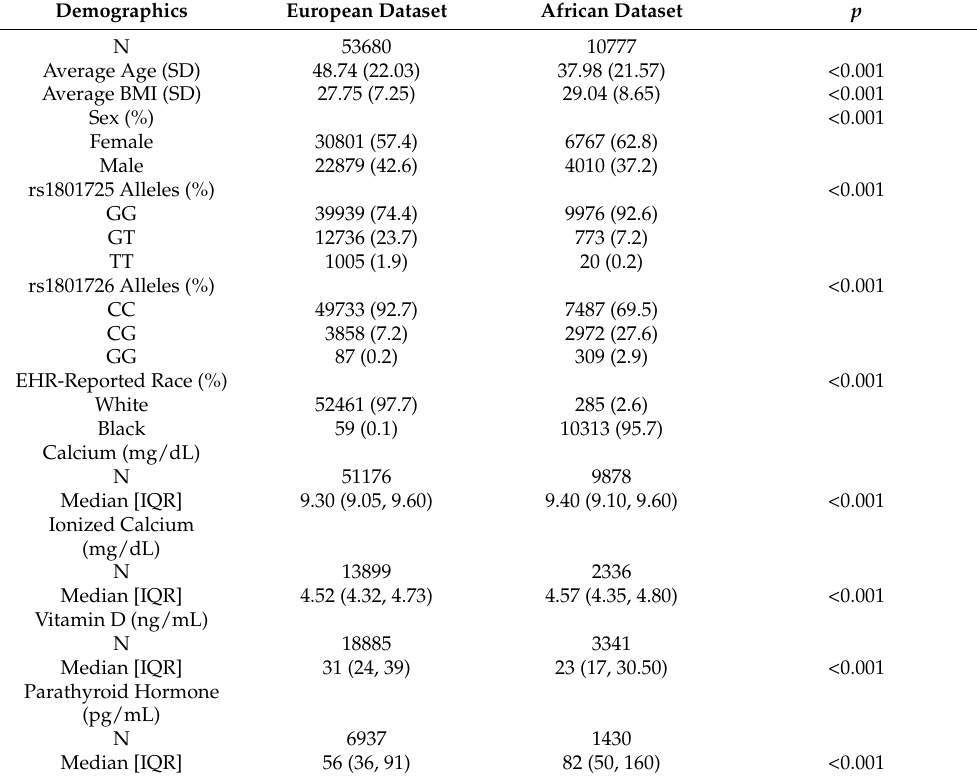
Table 1. Descriptive statistics for European and African descent